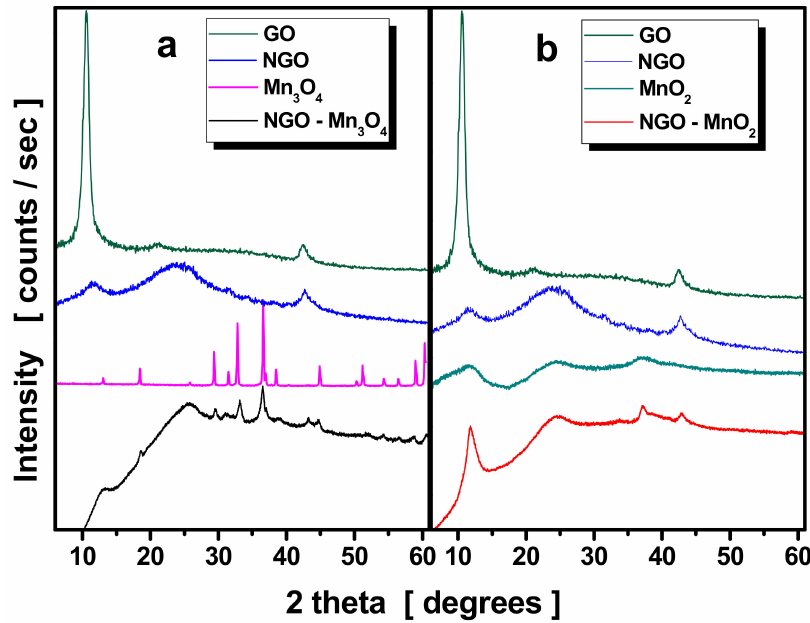
Figure 1. XRD patterns of: ( a ) graphene oxide (GO), modified graphene oxide (NGO), manganese oxide (Mn 3 O 4 ) and NGO–Mn 3 O 4 nanocomposite; ( b ) GO, modified graphene oxide (NGO), manganese oxide (MnO 2 ) and NGO–MnO 2